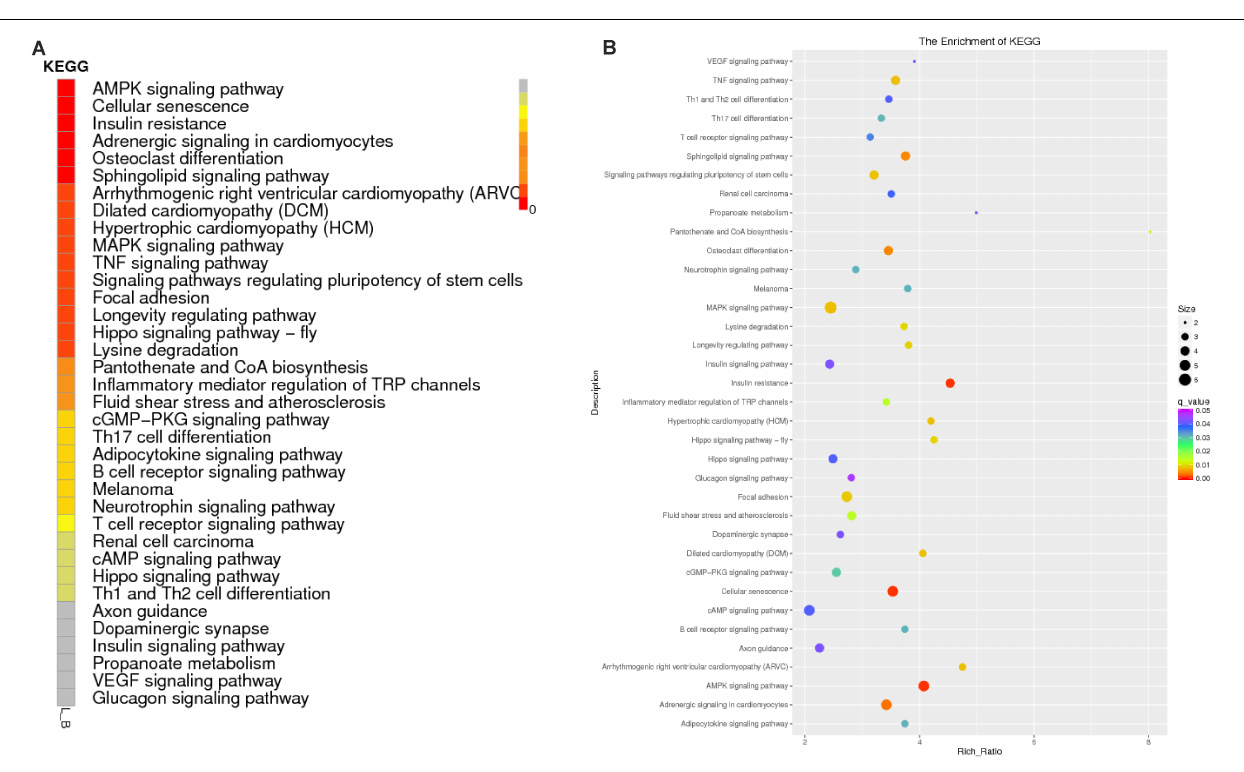
there were obvious differences in the apparent observation of the muscle fibers of HE stained paraffin sections of the longissimus dorsi of Shandong black cattle and Luxi cattle. The length of